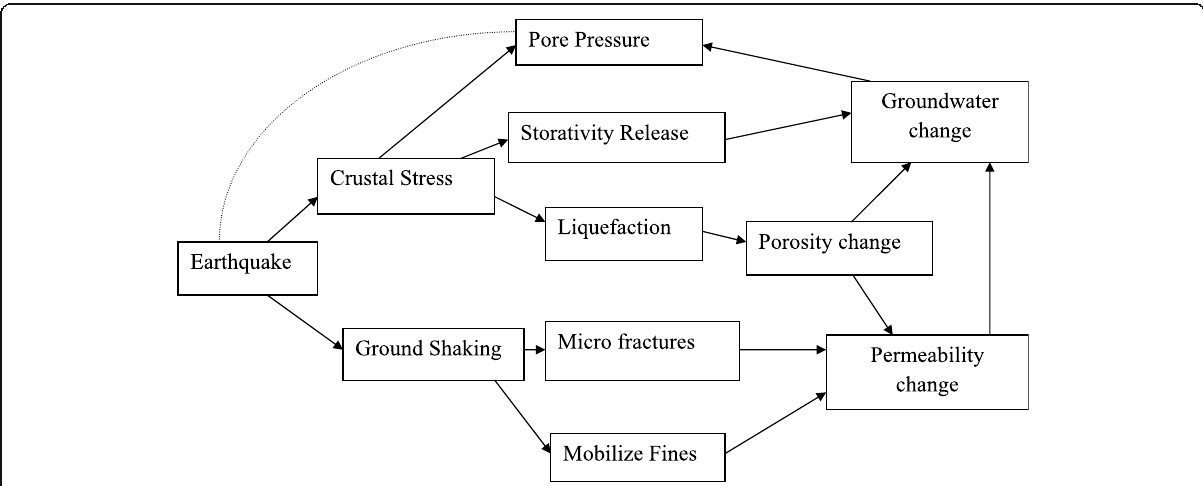
Fig. 4 Relationships between earthquakes and groundwater processes (adapted from: http://seismo.berkeley.edu/~manga/eps200-2006.html